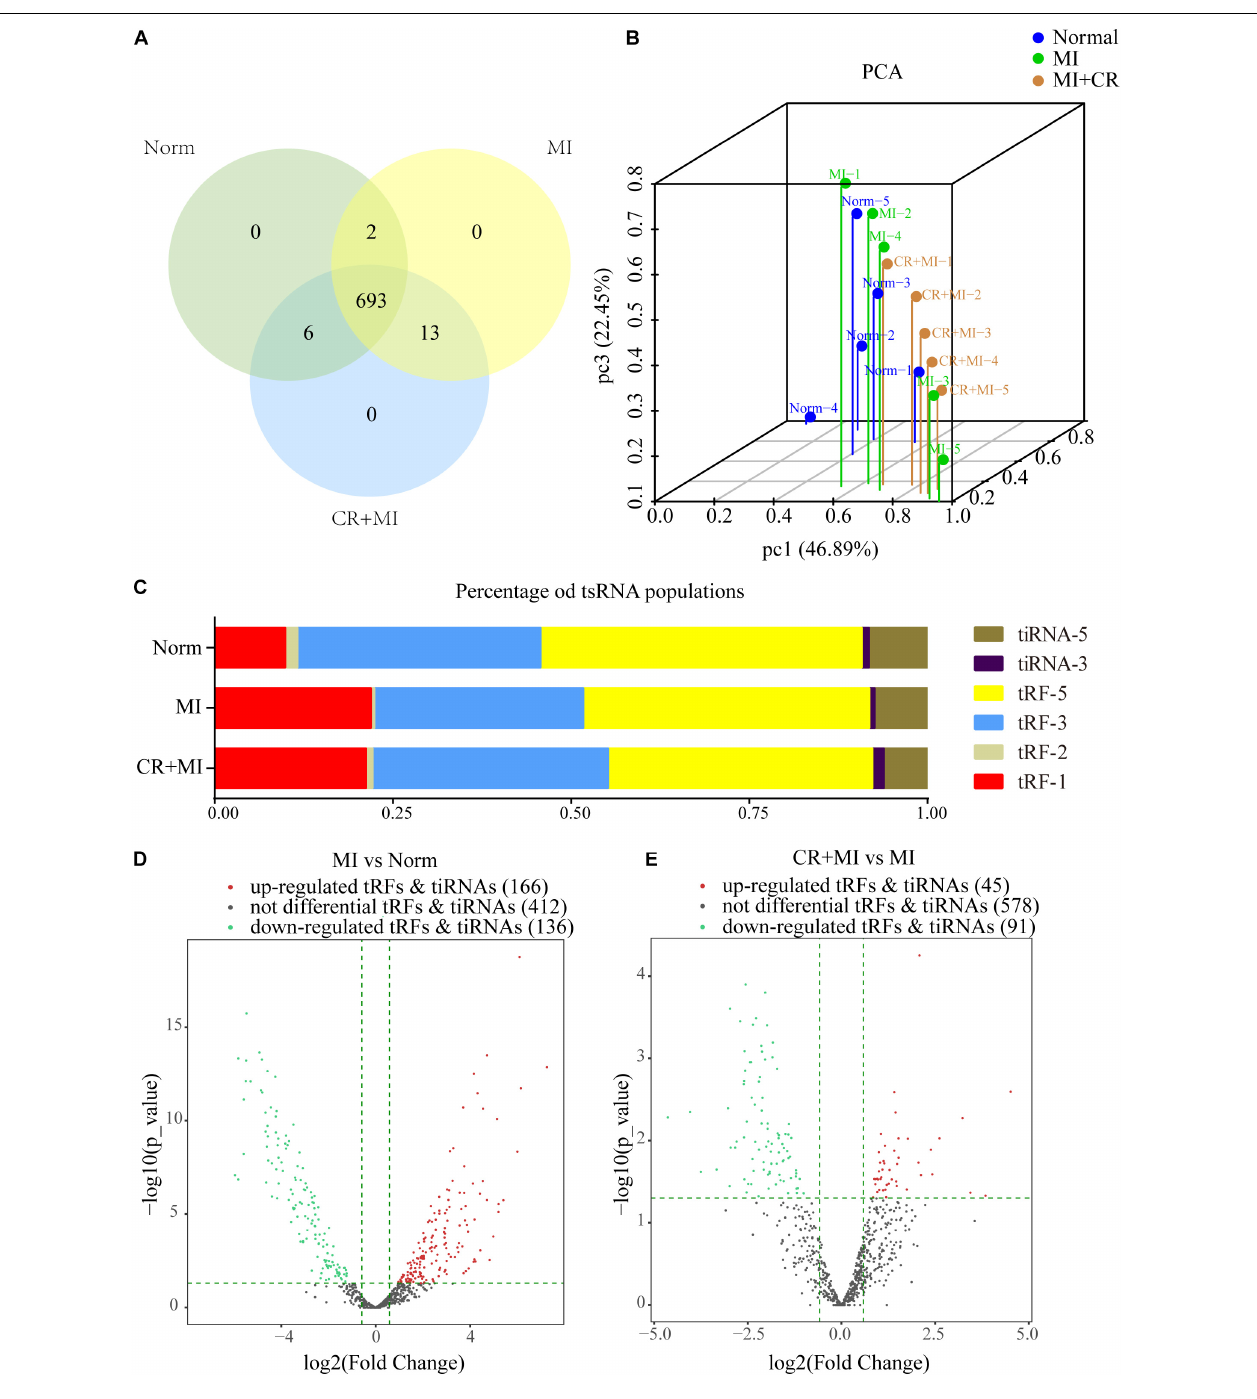
FIGURE 3 | Altered expression profiles of tsRNAs following CR pretreatment. (A) Venn diagram indicating the total number of exact-matched tsRNAs in the myocardial tissues of norm, MI, and CR + MI groups. (B) PCA plot illustrating the clustering of three repeats in each group and evaluation of the corresponding variability and repeatability (FC > 1.5 and P < 0.05). The blue dots represent the norm group, the green dots represent the MI group, and the orange dots represent the CR + MI group. (C) Histogram showing the expression levels of each subtype of tsRNA in norm, MI, and CR + MI groups. (D) Volcano plot showing 302 significantly altered tsRNAs between the MI and norm groups (FC > 1.5 and P < 0.05). (E) Volcano plot showing 136 significantly changed tsRNAs between MI and CR + MI groups (FC > 1.5 and P < 0.05). Red indicates upregulated tsRNAs, and green denotes downregulated tsRNAs. The data are presented as the mean ± SEM ( n = 5). * P < 0.05, ** P < 0.01 compared with the MI